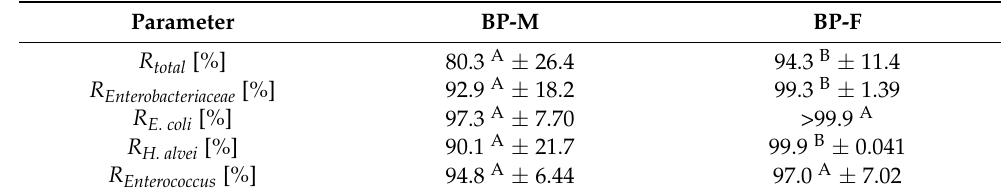
Table 8. Comparison of the degrees of reduction in selected microorganisms in the individual biogas